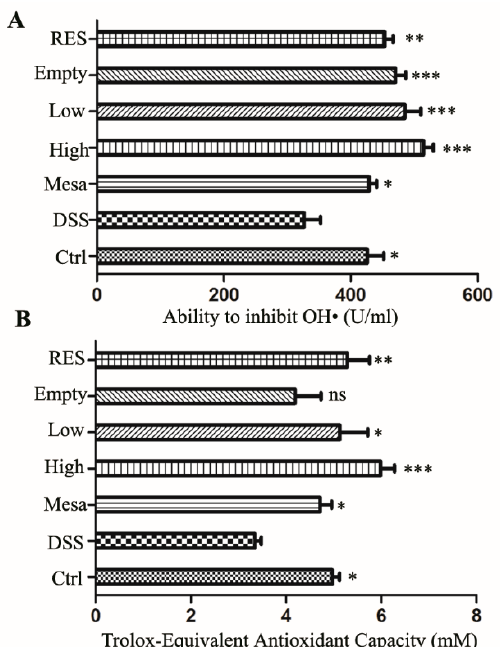
Figure 10. Determination of the ability to inhibit OH • ( A ) and total antioxidant capacity were deter- mined by ABTS ( B ). Analysis of variance (ANOVA) and Bonferroni post-test (* p < 0.05; ** p < 0.01; *** p < 0.001; ns, no significance) were used to assess statistical significance.